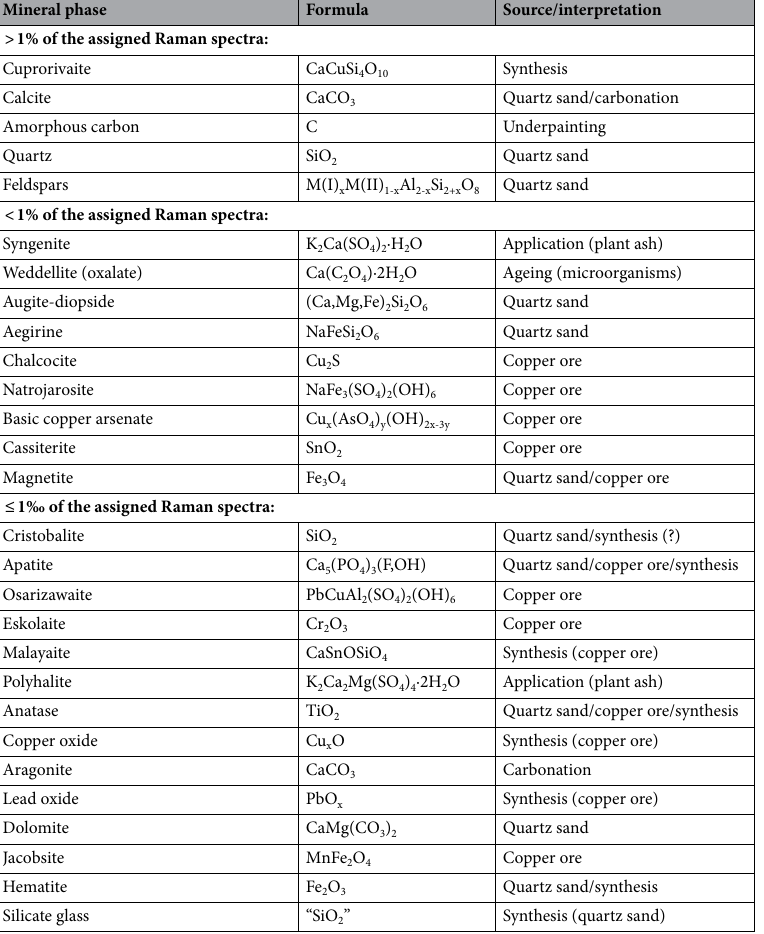
Table 1. Minerals identified in the paint layer by Raman